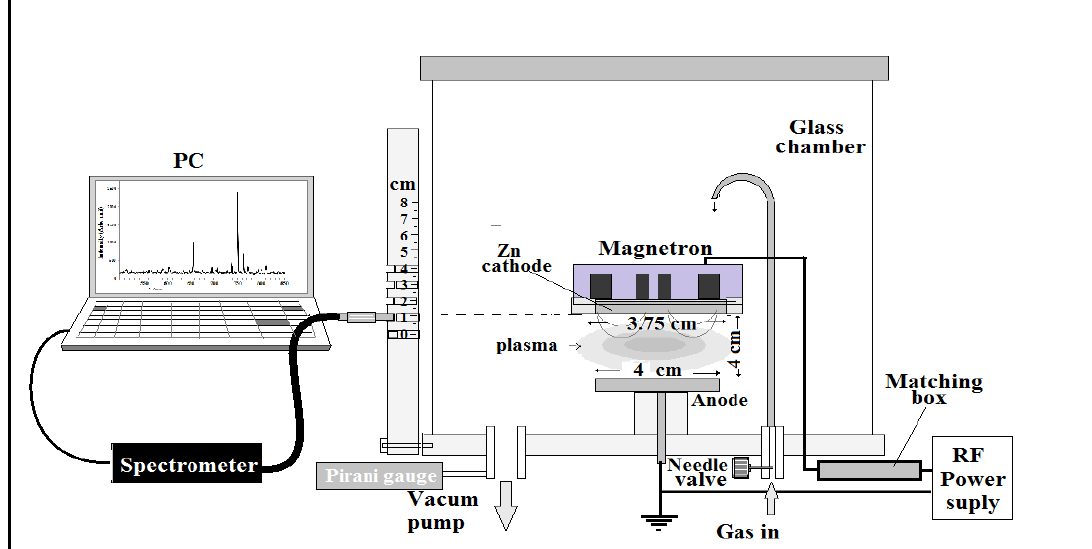
Fig. 1: Schematic diagram of plasma magnetron sputtering